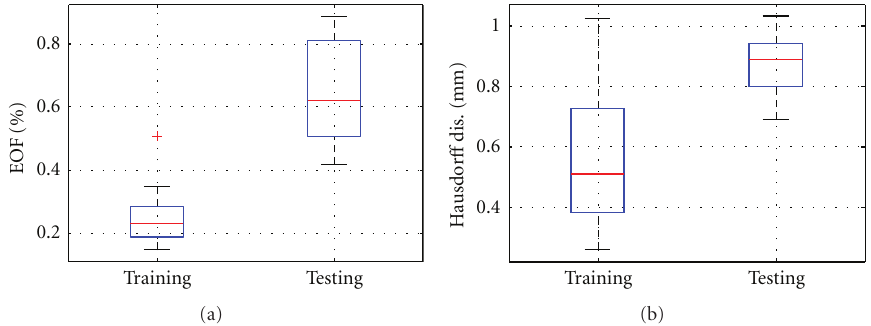
Figure 15: Images of three porcine kidneys for experiment.